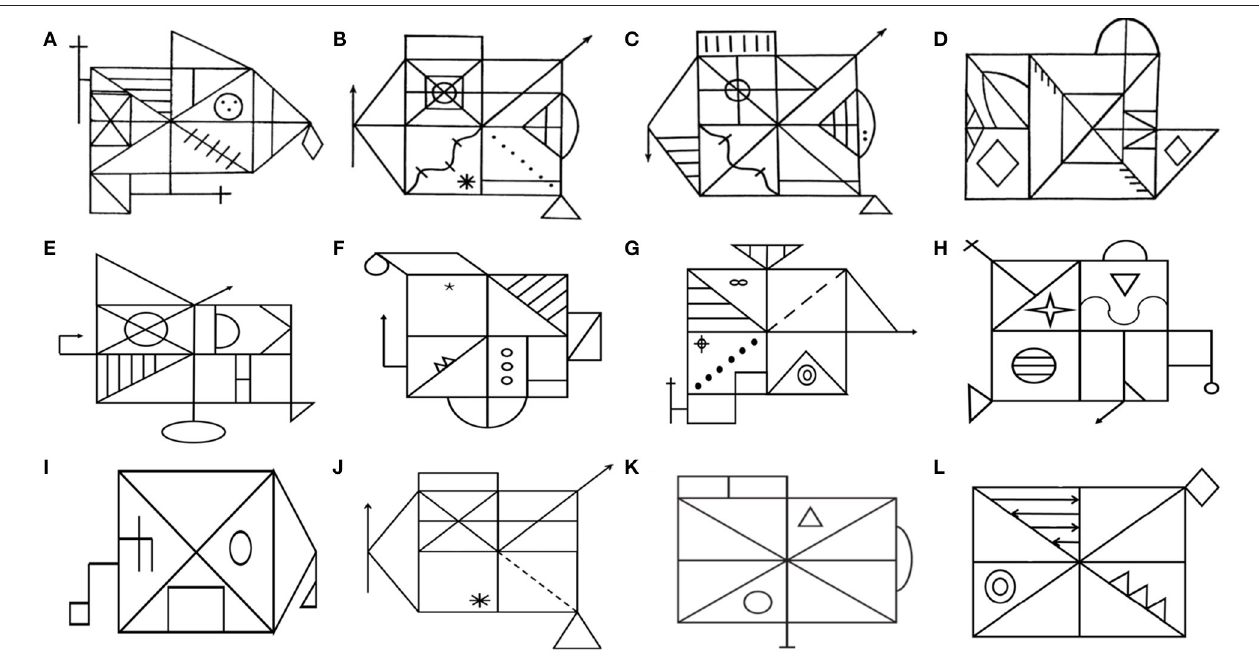
FIGURE 1 | Equivalent and simplified versions of Rey–Osterrieth Complex Figure (ROCF). In 1941, Rey developed the classic ROCF (A) . To avoid the learning effect by using the same figure twice, some studies have developed multiple equivalent versions of the ROCF, such as the Taylor figure (B) , the modified Taylor figure (C) , the Mark figure (D) , and various versions of the Medical College of Georgia Complex Figures (E–H) . Subsequently, multiple simplified versions of ROCF (I, K, L) were developed. The Benson figure (I) is less affected by executive function. (K) has been proven to be suitable for the elderly. Kim developed (L) for digital assessment tools. Similarly, the simplified Taylor figure (J) has also been confirmed to suit the low-educated